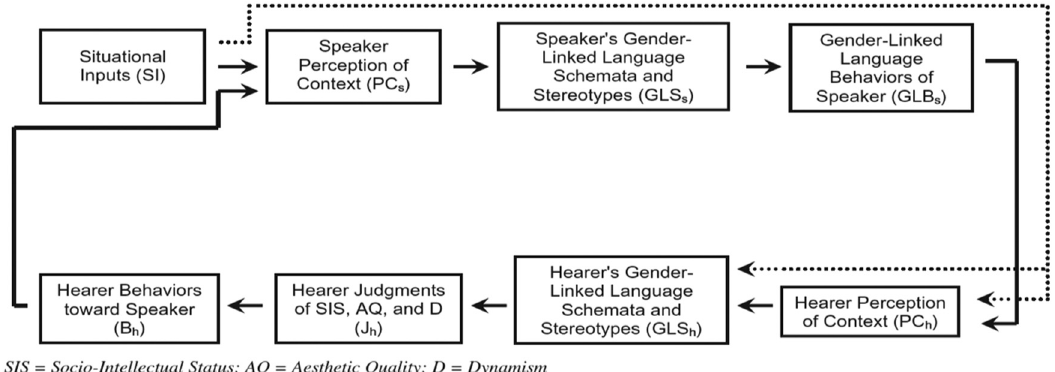
Figure 1: The gender - linked language e ff ect model ( from Mulac et al., 2013: 24 )